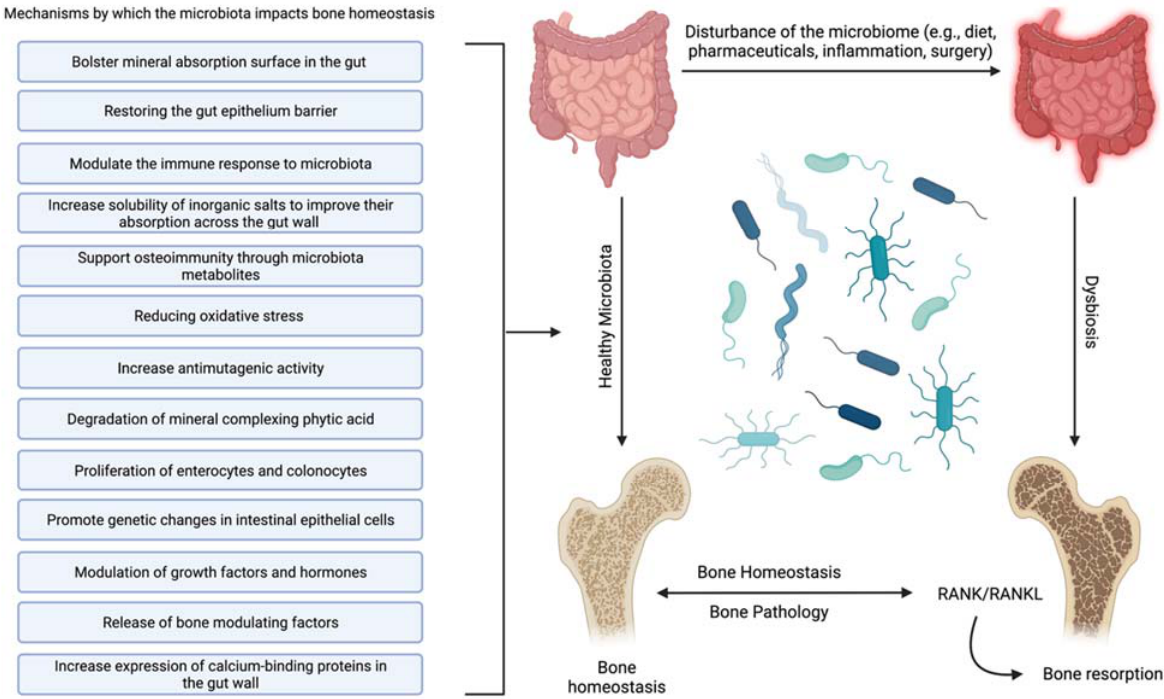
Figure 1. Mechanisms of interaction between the human gut microbiota and bone that lead to increased bone mineral density or suppression of osteoporosis. Created with BioRender.com.